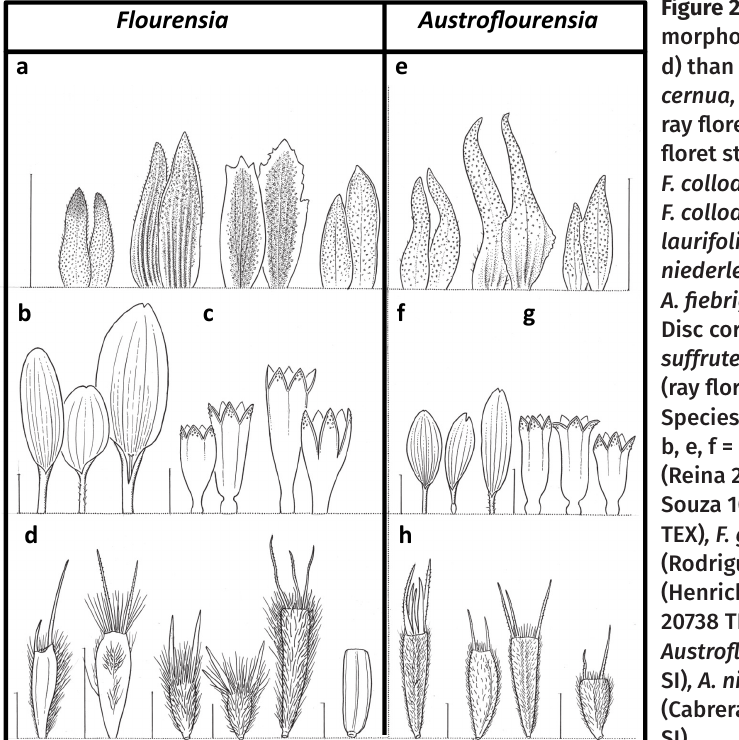
Figure 2. Floral characters showing greater morphological divergence among Flourensia s.s. (a- d) than among Austroflourensia (e-h): a. Phyllaries: F. cernua, F. collodes, F. dentata, F. glutinosa . b. Neuter ray florets: F. collodes, F. glutinosa, F. monticola (ray floret styliferous) . c. Disc corollas florets: F. cernua, F. collodes, F. glutinosa, F. ilicifolia . d. Achenes: F. collodes, F. cernua, F. ilicifolia (central two) , F. laurifolia, F. solitaria. e. Phyllaries: A. fiebrigii, A. niederleinii, A. suffrutescens. f. Neuter ray florets: A. fiebrigii, A. niederleinii, A. suffrutescens . g. Disc corollas florets: A. fiebrigii, A. niederleinii, A. suffrutescens . h. Achenes: A. thurifera, A. niederleinii (ray floret with ovary) , A. fiebrigii, A. suffrutescens . Species are shown from left to right. Scale bars: a, b, e, f = 5 mm; c, d, g, h = 2 mm. Flourensia cernua (Reina 2003-1243 TEX) , F. collodes (Cronquist &